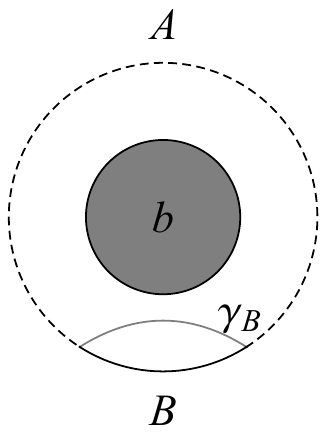
Figure 22 . Schematic representation of the random tensor network model studied in section 5.3. b indicates the bulk region with the incoming legs, B is the unmeasured boundary subregion, and the dashed line along subregion A on the boundary indicates measurement. γ homologous to B